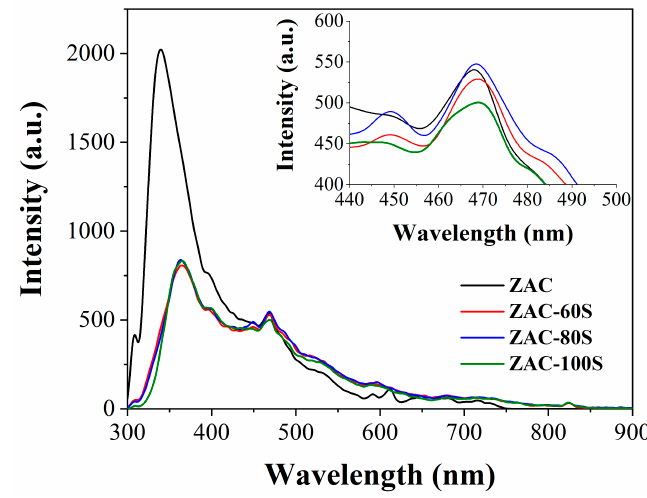
Figure 5. Photoluminescence spectra of the sulfured ZnAlCd materials.